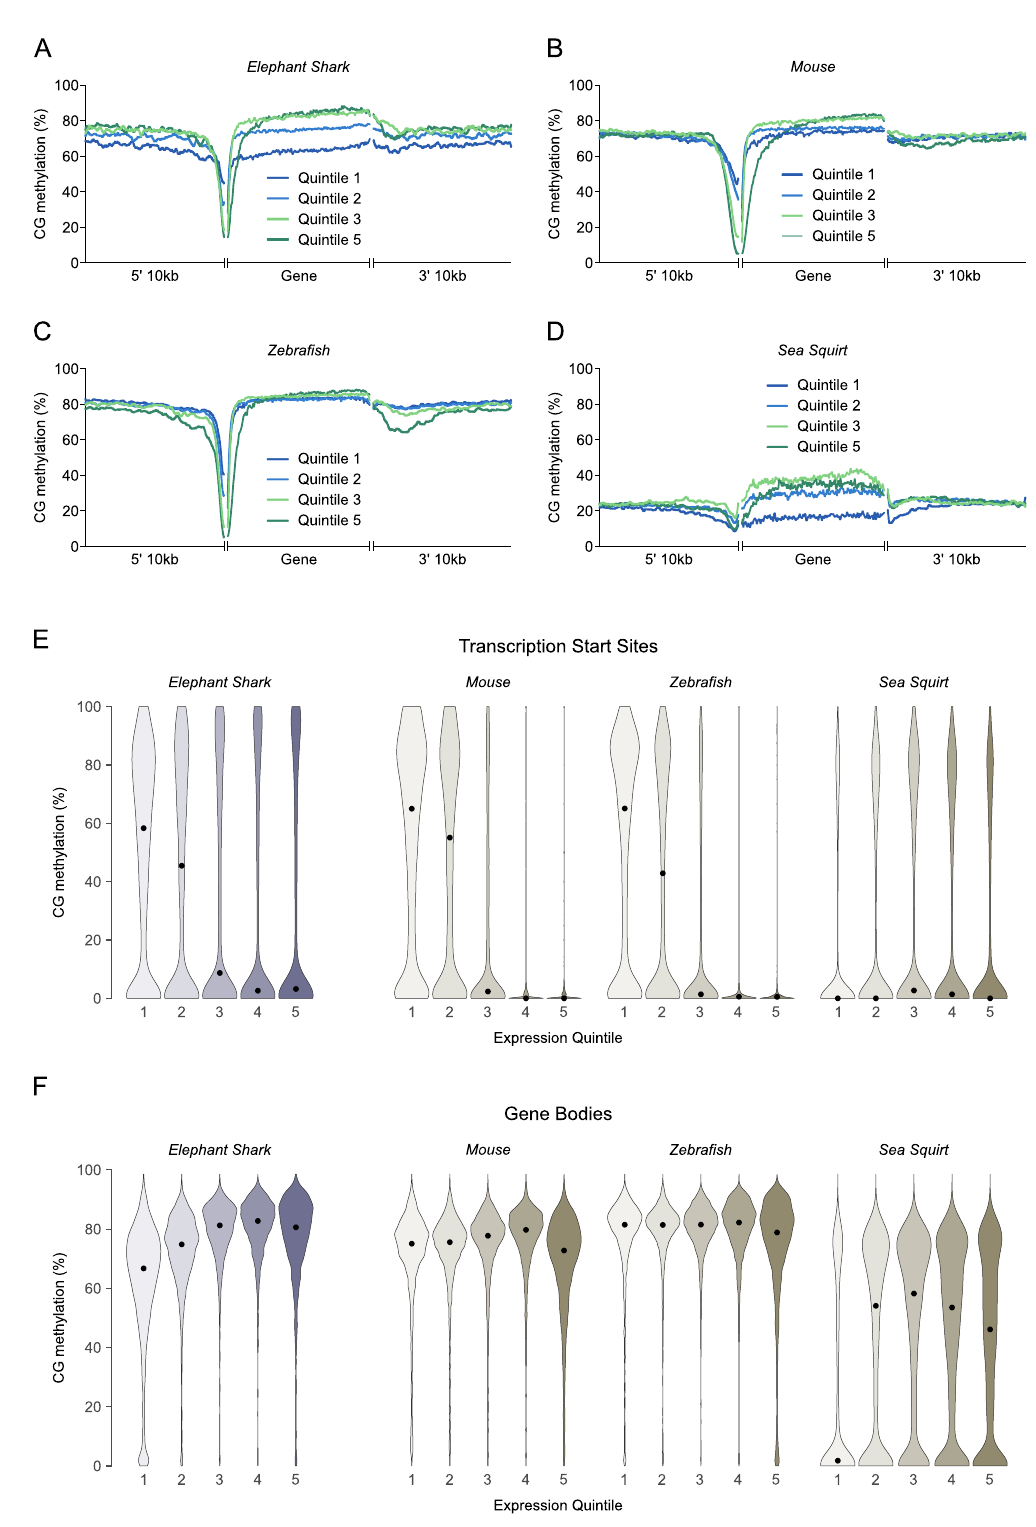
Figure 5. Relationship between methylation and gene expression. A – D: Mean CG methylation across genes and 10kb flanking regions, classified into quintiles according to expression level in RNA-seq datasets (5 = highest). Quintile 4 is omitted for clarity. Quantification was performed at the level of individual CG dinucleotides. Flanking regions were smoothed by averaging 100 neighbours. E – F: Distribution of methylation at the transcription start site ( E ) and within the body ( F ) of genes classified into quintiles according expression level (5 = highest). Each violin is scaled to the same maximum width (total area is not constant between violins) to demonstrate distributions for each quintile. Black dots denote the median.